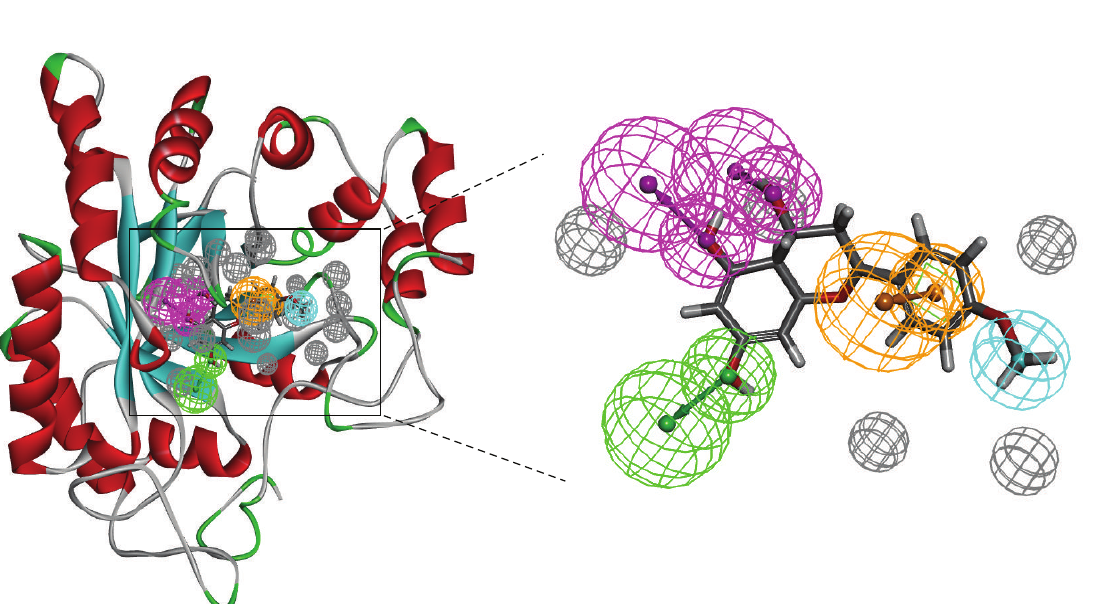
Figure 8: Receptor-ligand interaction based pharmacophore model with five chemical features represented in spheres illustrated in different colors such as green (HBA), magenta (HBD), brown (RA and PI), cyan (HY), and 23 exclusion volumes (grey spheres). The zoomed view of the pharmacophore model has been shown in the right side with less exclusion spheres present in 1.1 ˚A distance for